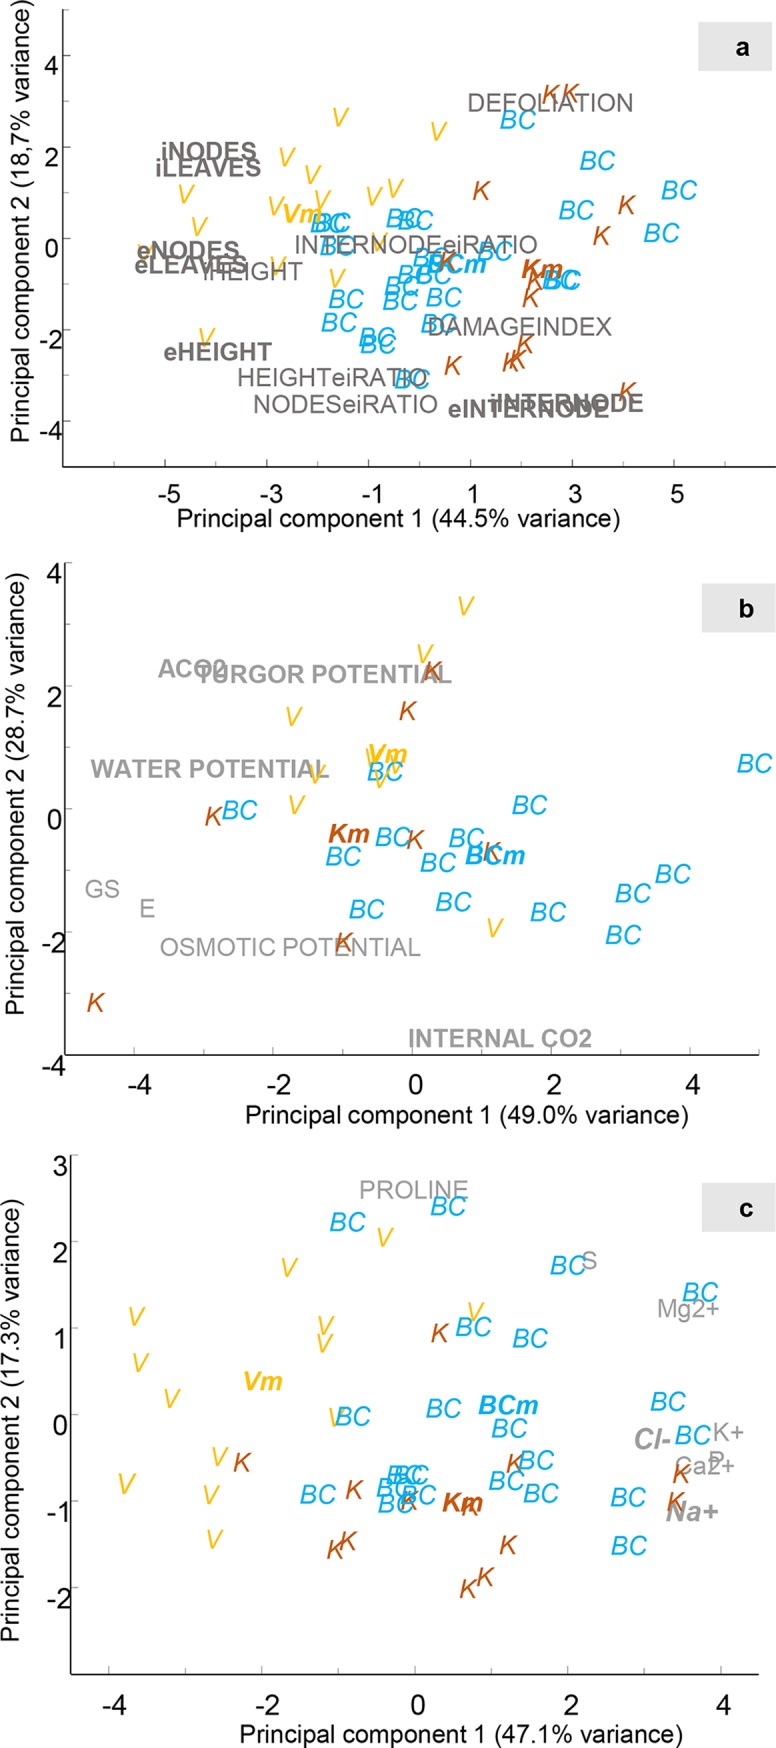
Plot of the first two components from a principal component analysis of morphological (a), leaf gas exchange and leaf water relations (b) and ionic and proline content (c) of the three populations in non-saline conditions. Each letter represents each population: V–D. virginiana population (yellow), K–D. kaki population (brown) and BC–Backcross population (blue). Vm, Km and BCm in bold represents the mean of the individuals. Gray letters represent each of the measured variables. The most important variables identified in each PCA are in bold type.